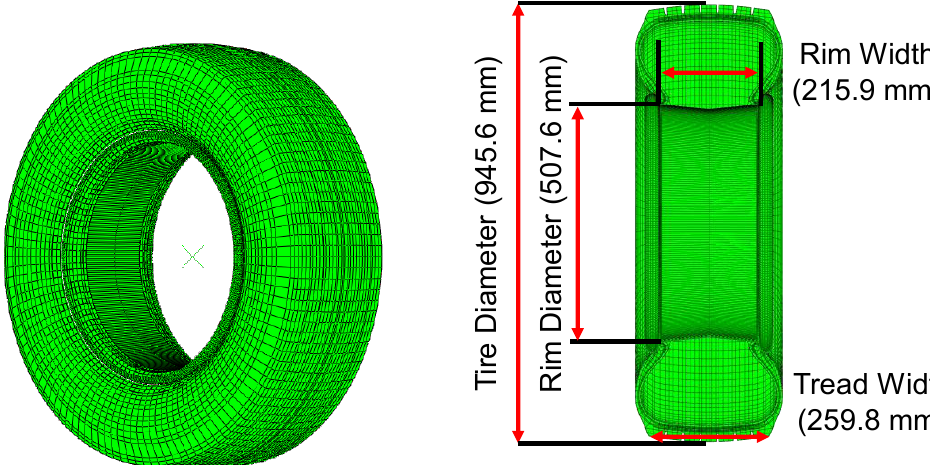
Figure 1. Dimension of the simple tread tire